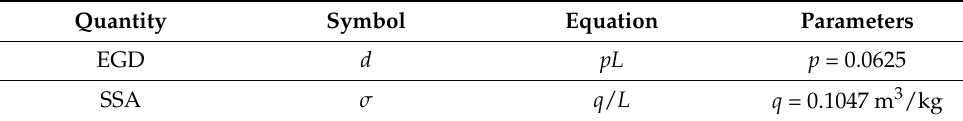
Table 3. The relationships between the values of EGD, SSA and EAL. Quantity Symbol Equation Parameters